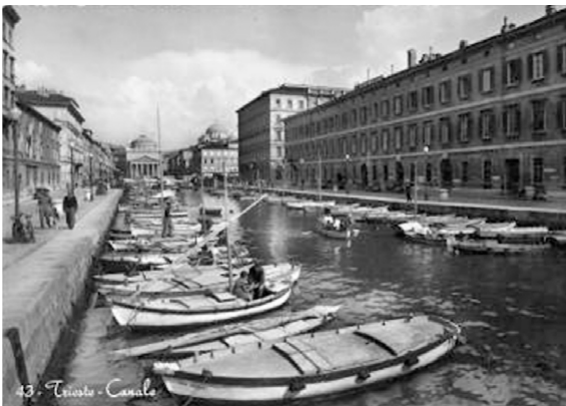
fig. 2. The Canal Grande (photo by Stengel &